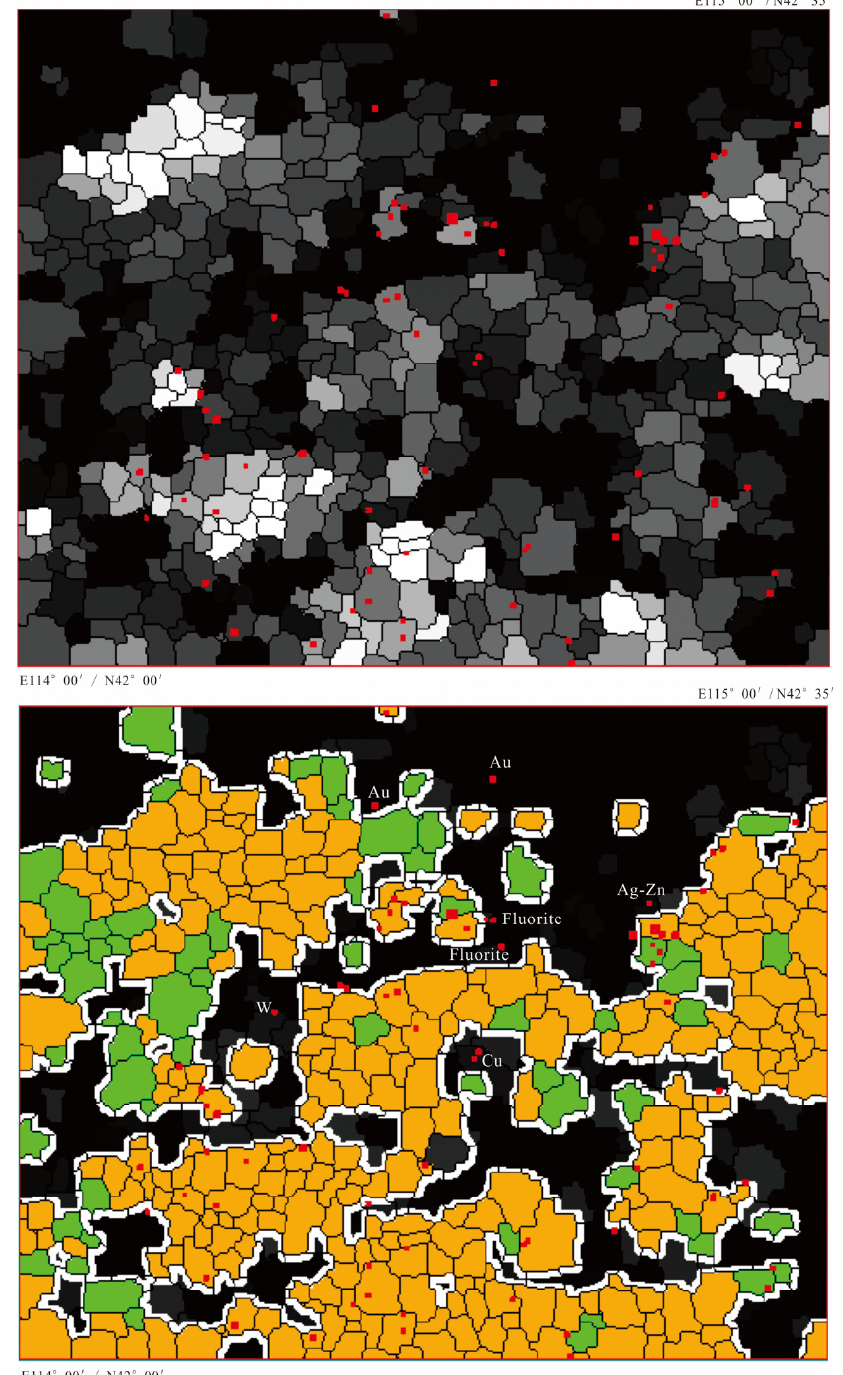
Figure 11. (upper) the object-based anomaly-score base map with all the known ore spots (red squares) overlaid on it; (lower) the buffered anomalous regions (green- and orange- colored patches edged with white) with ore spots overlaid on it. Note: the mineral species of the ore spots include Cu, Au, Fe, Mo, Hg, Ag-Pb-Zn-Fe, Ag-Pb-Zn, Pb-Zn, Cu-Zn, Ag-Pb, Pb, Zn, W, Nb-Ta, Rb-Nb-Ta, Fluorite, W-Mo, Beryl, U, etc. Other legends in this figure are consistent with those in Figure 9 if not specified.